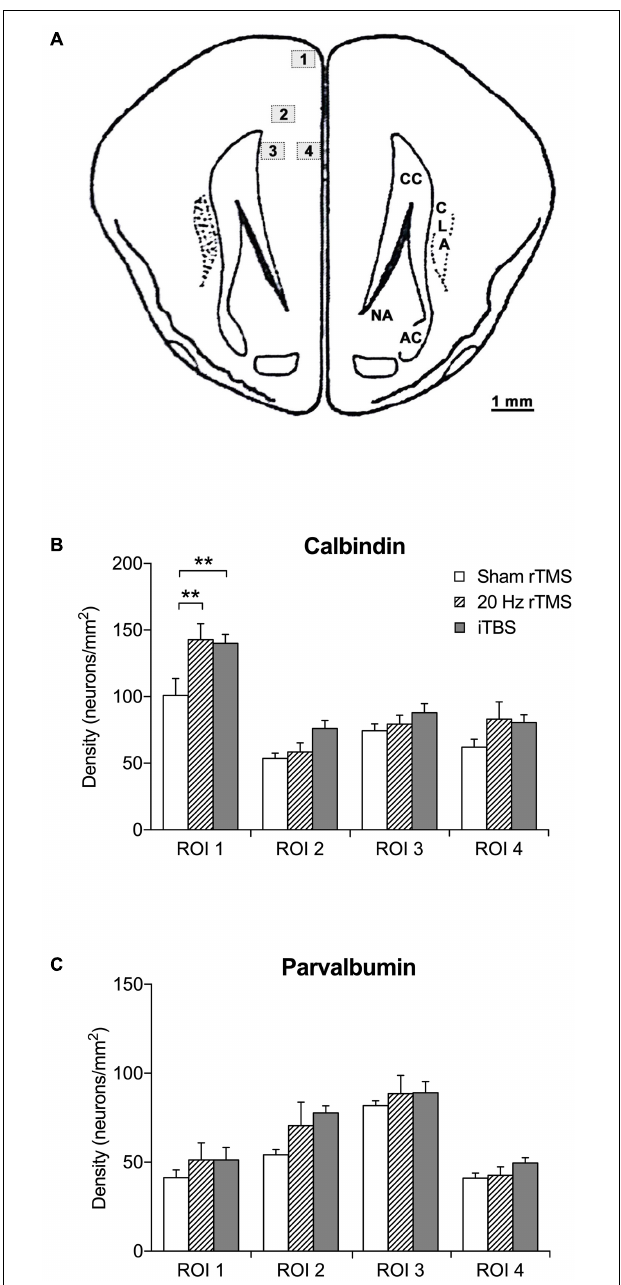
FIGURE 6 | Regions of interest and density of calbindin- and parvalbumin-positive neurons in the PFC. (A) Schematic illustration of location and area size of regions of interest (ROI). The counting frame area was set to 0.24 mm 2 using a X20 objective lens. The mean density per mm 2 was calculated by the mean number of calcium-binding immunoreactive neurons divided by the frame area (mm). Numbered boxed (1–4) represent locations and area (mm 2 ) of ROI. Image adapted from Rapisarda and Bacchelli (1977). (B) Mean density of calbindin-positive neurons in sham ( n = 6), 20 Hz rTMS ( n = 6), and iTBS ( n = 7) treated animals within four ROI in the PFC. (C) Mean density of parvalbumin-positive neurons in sham ( n = 6), 20 Hz rTMS ( n = 6), and iTBS ( n = 7) treated animals within four ROI in the PFC. All data mean + SEM, repeated measures ANOVA with Sidak’s multiple comparisons; ** p <